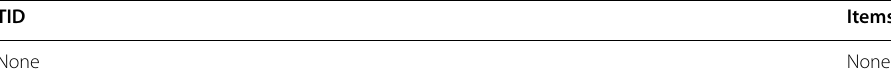
Table 6 Transaction partition 2